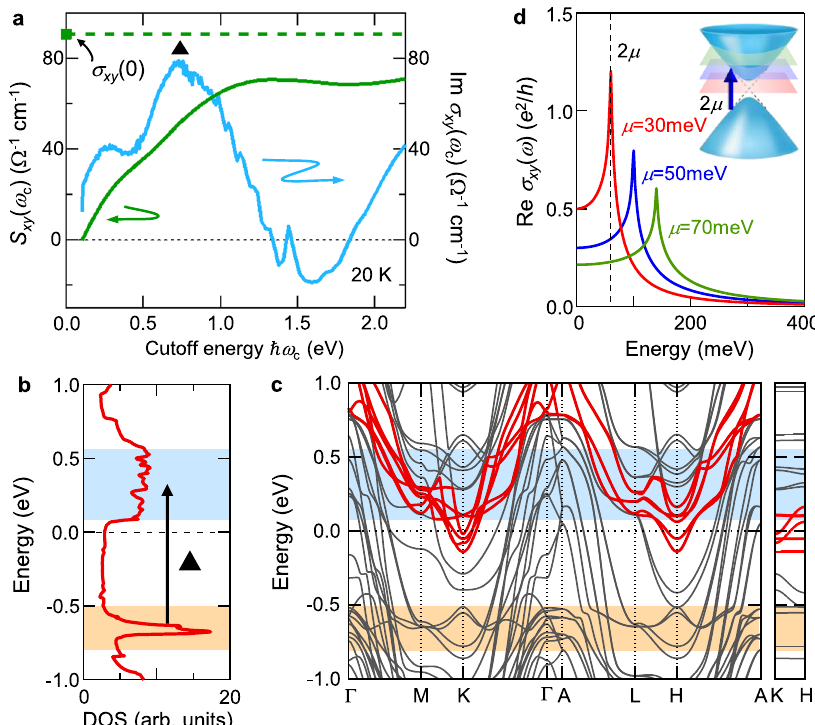
Fig. 4 Two distinct band structures inducing large AHE. a The spectral weight S xy ( ω c ) (green solid curve) and Im σ xy ( ω ) spectra (light blue curve) up to 2.2 eV (see the main text for the de fi nition of S xy ( ω c )). The dc AH conductivity at 20 K, 0 T ( σ xy (0)) is indicated by the square at = 0 and dashed green horizontal line. b The calculated DOS. The transition indicated by the triangle is ascribed to the higher-lying ω c resonance observed in Figs. 3d and 4a. The shaded regions in orange and blue denote the large DOS due to the fl at bands, some of which are also indicated by the green curve in Fig. 1d. c The band structure with the SOC. Red curves represent six bands composing the nodal lines around Fermi level. d The real part of the optical Hall conductance spectra σ xy ( ω ) calculated for a two-dimensional single band-crossing point for various Fermi level μ (see Supplementary Note